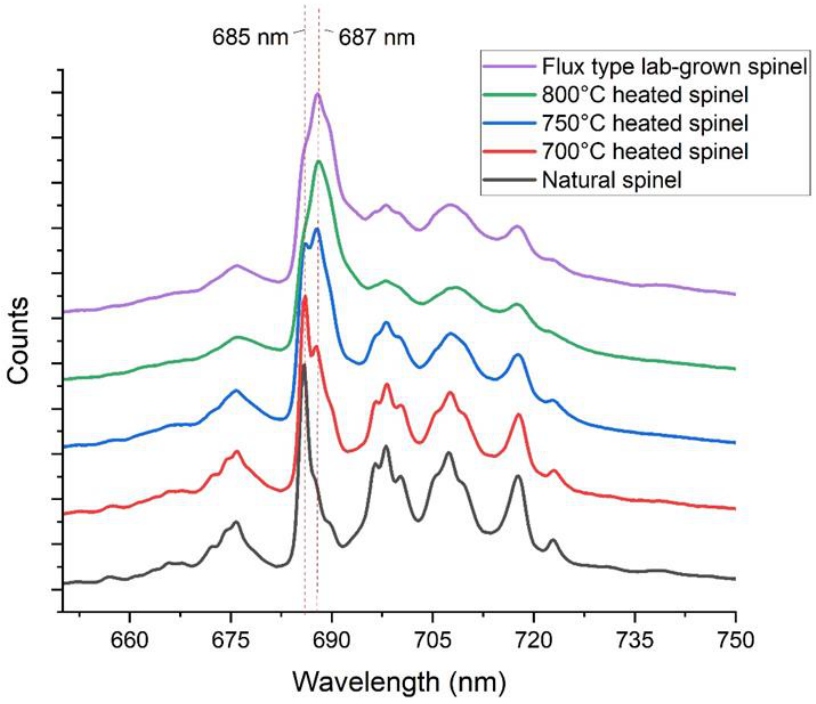
Figure 1. Photoluminescence spectra of the natural, heated, and flux lab-grown